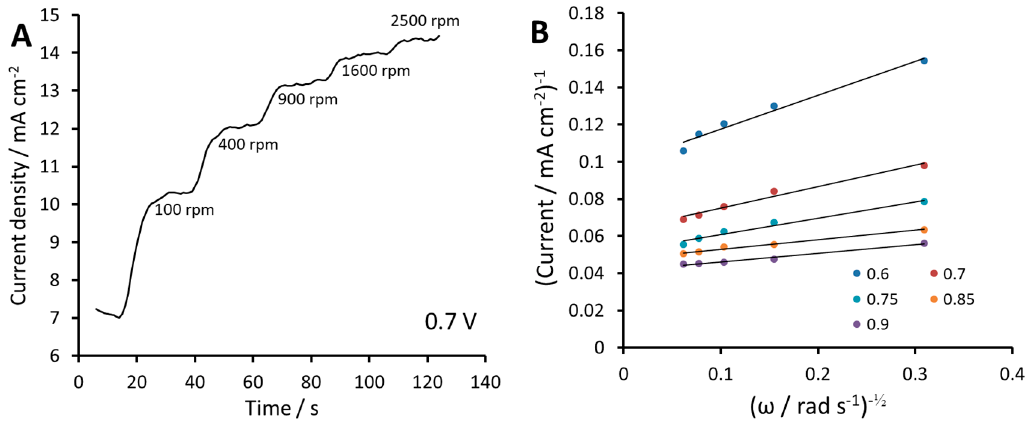
Figure 6. Pt 20 /C catalyst: ( A ) Experimental constant potential curve measured at different sweep rates (0.7 V vs. SHE) measured in 0.1 M EtOH solutions (Ar purged) with 0.5 M H 2 SO 4 as the supporting electrolyte; and ( B ) Koutecky–Levich plots. Currents are normalized to electrode geometric surface area.